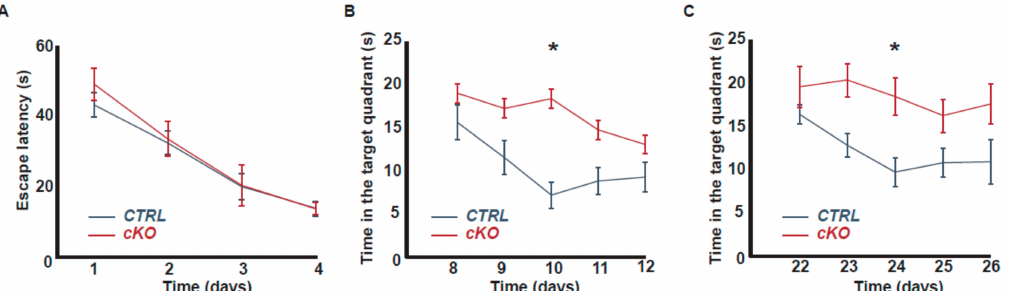
Figure 2. Trpc1 gene deletion impairs reference memory extinction. Morris Water Maze (MWM)